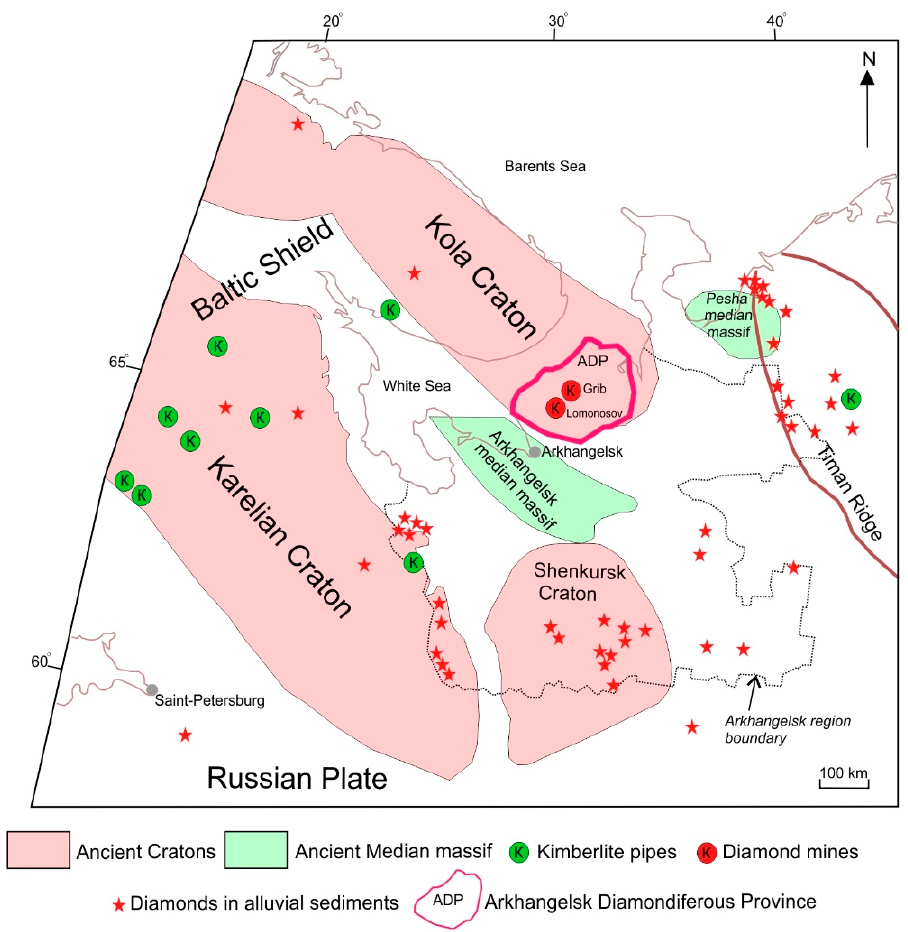
Figure 1. Tectonic scheme of the northern East European platform, adapted from [1].